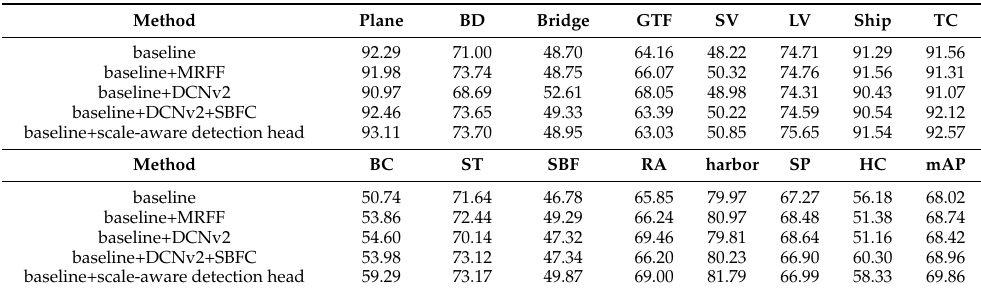
Table 2. The impact of different part in scale-aware detection